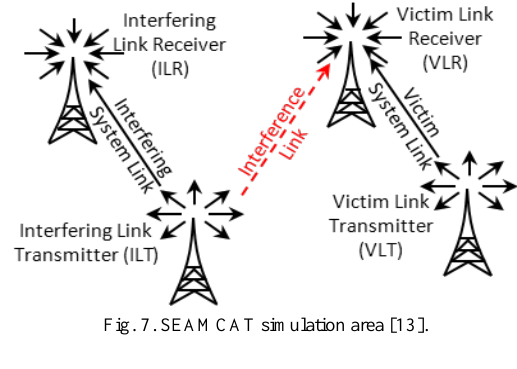
Fig. 7. SEAMCAT simulation area [13].